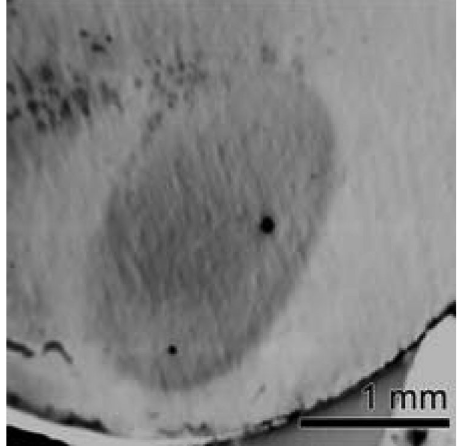
FIG. 9. ABS image of the sputtered spot (the elliptical-shaped grey zone). It seems the Ar þ beam cleaned the surface layer (less charging effect after sputtering).